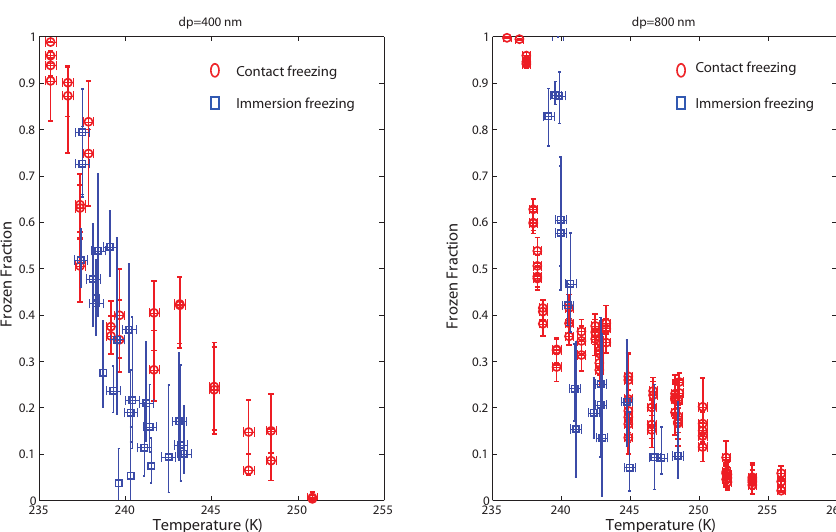
Fig. 14. Comparison of contact freezing and immersion freezing results for kaolinite particles. Red circles represent the contact freezing experiments for cloud droplets of 26µm (in diameter) with a residence time of 5 s, whereas the blue squares represent the immersion freezing data with a droplet diameter of 6µm. dp refers to the aerosol particle